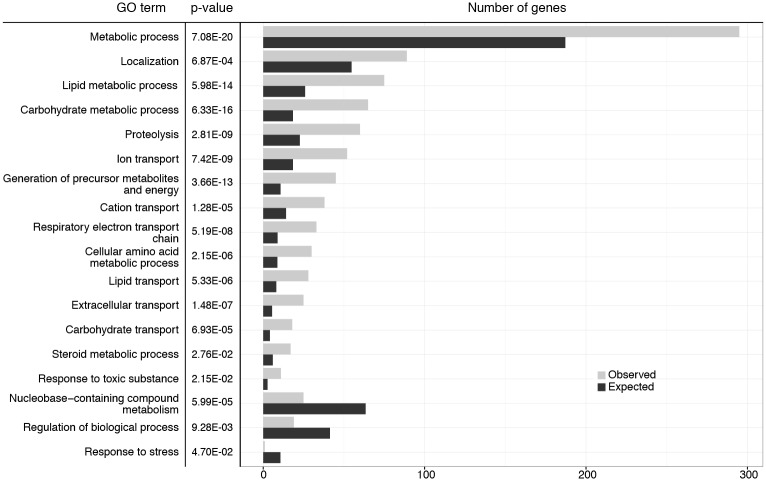
Expression analysis identifies metabolism genes as altered in HP1b mutants.GO terms significantly enriched (top) or depleted (bottom three terms) are reported along with the relevant p-values. The bar graphs show the observed (grey) and expected (black) number of genes associated with each GO term. GO terms show are top level terms from GO SLIM. For the results for all GO SLIM terms, see S2 Table. For the results from the basic GO term analysis see S3 (upregulated genes) and S4 (downregulated genes) Tables.